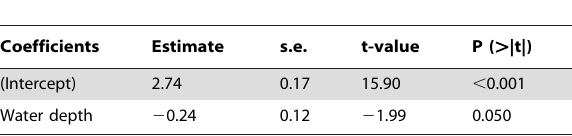
Table 1. Linear regression analysis examining the effects of aircraft type, shark analogue type, water depth, day and various environmental variables on sighting